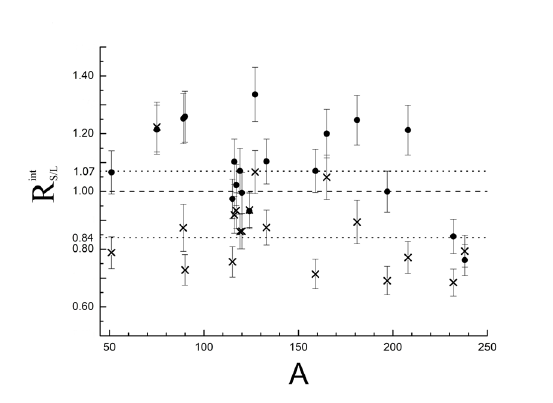
, (circles - 1n, crosses - S / L